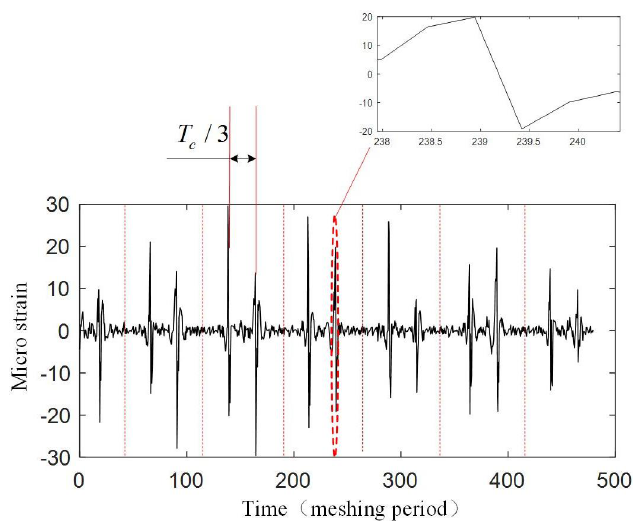
Figure 21. Strain signal measured by FBG1.